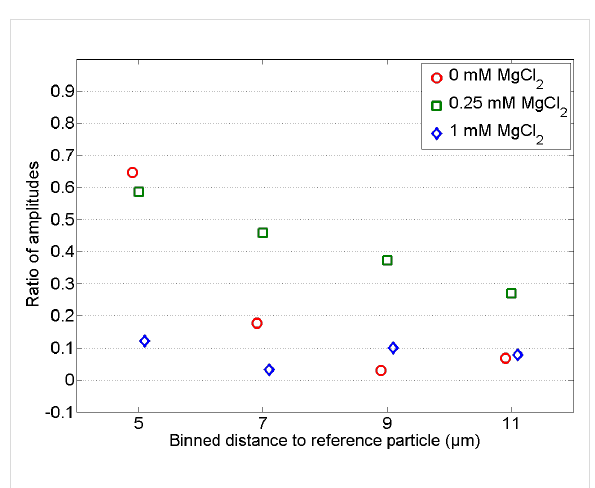
Figure 3: Ratios of excitation and response dependent on the binned distance between reference and response particle. Different markers show varying crosslinker concentrations. Red circles: 0.00 mM MgCl 2 , green squares: 0.25 mM MgCl 2 , blue diamonds: 1.00 mM MgCl 2 . Higher crosslinker concentrations evoke a stiffer network